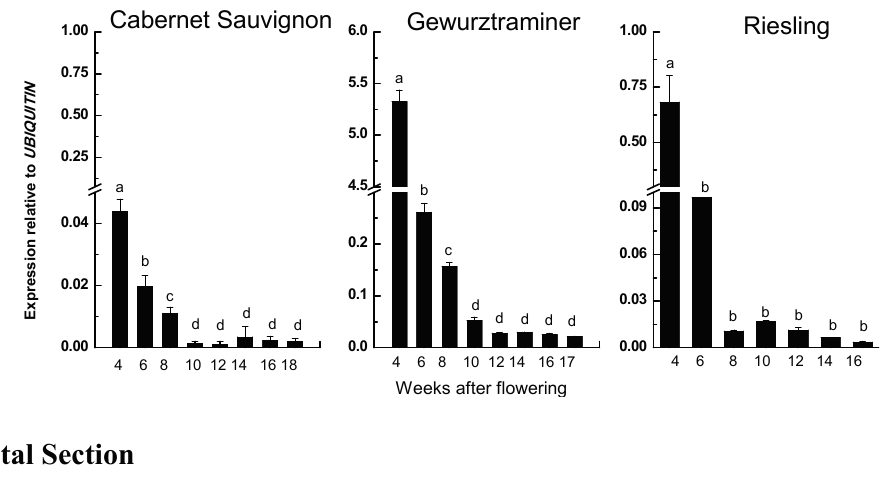
Figure 6. VvLinNer relative expression in developing grape berries. Each data point is the mean of six values (multiplying three biological replicates by two technical replicates) and their standard deviation. Different letters (a–d) indicate that the transcript abundance of the gene had significantly difference at p < 0.05 according to Duncan’s multiple range test in